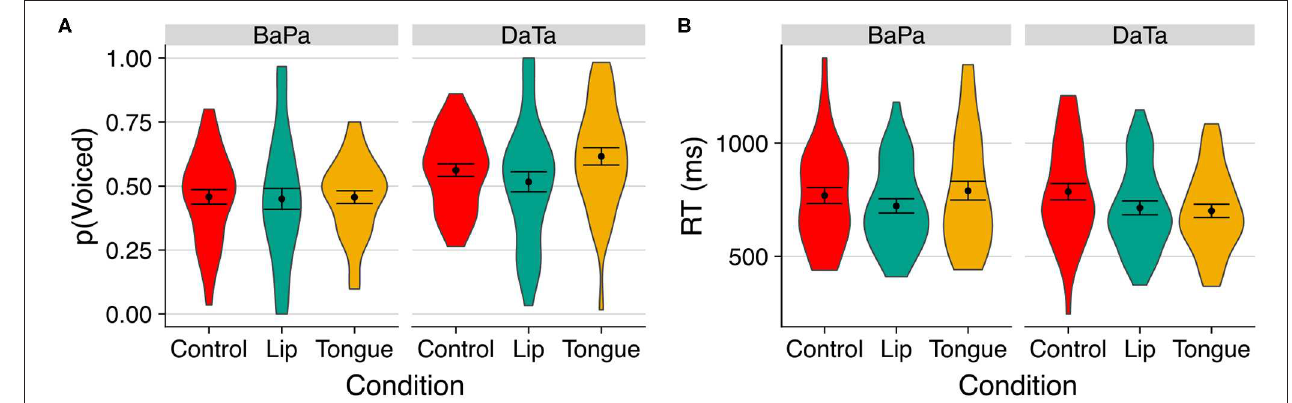
FIGURE 3 | The effect of stimulation on the perception of voicing of labial and coronal sounds in Experiment 1. (A) indicates proportion of voiced responses; (B) indicates response time to the voiced option. Error bars are standard error of the mean.